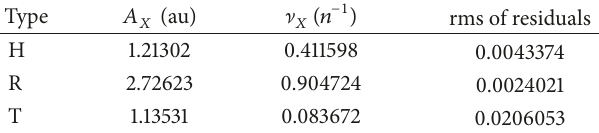
Table 2: Exponential fitting for H, R, and T graphene nanoislands.